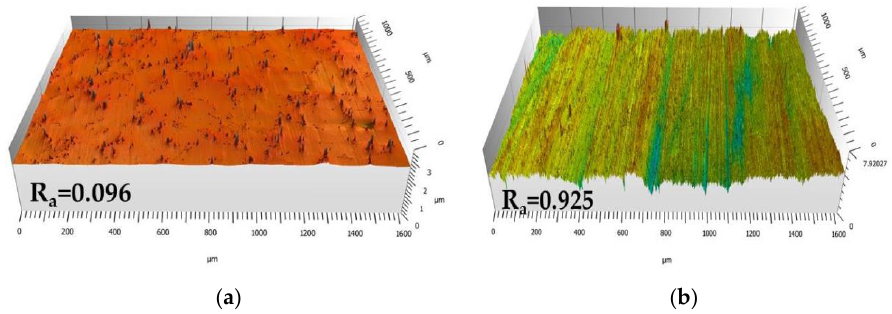
Figure 1. Three-dimensional reproduction of surface of Mar M 247 after: ( a ) Polishing up to 1 µm diamond paste; ( b ) Grinding using 80 grit sand paper performed using laser profilometer.